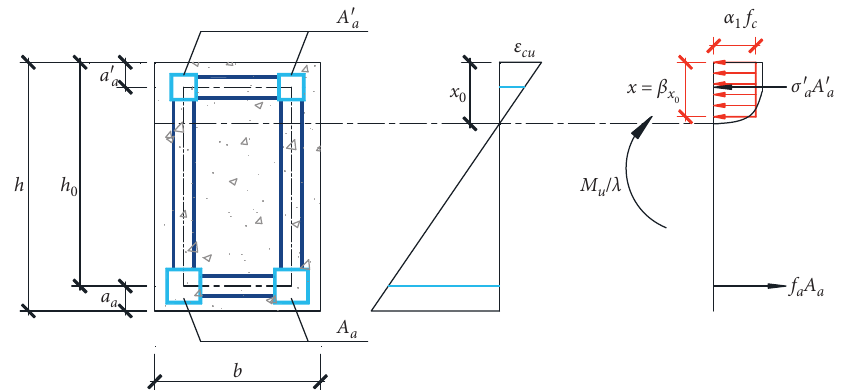
Figure 9: Calculation of flexural capacity of normal